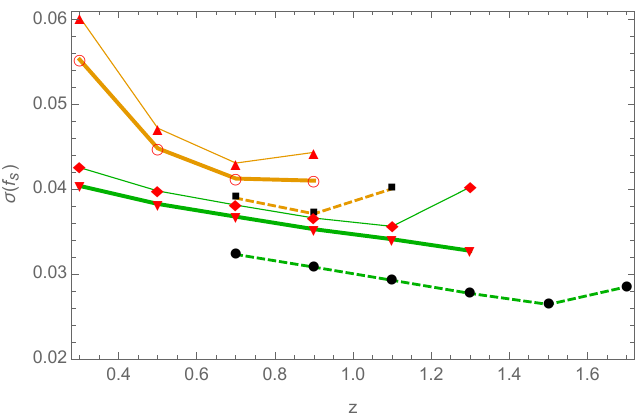
Figure 11. Forecasted constraints on the growth of structure ( f s = f σ 8 ) relative error from the galaxy catalogs produced by J-PAS (thick solid lines for 8500deg 2 , thin solid lines for 4000deg 2 ) as compared with DESI (dashed lines, 14,000deg 2 ). LRGs in mustard and ELGs in green. f is the growth rate of matter perturbation. Redshift bins of ∆ z = 0.2 are used